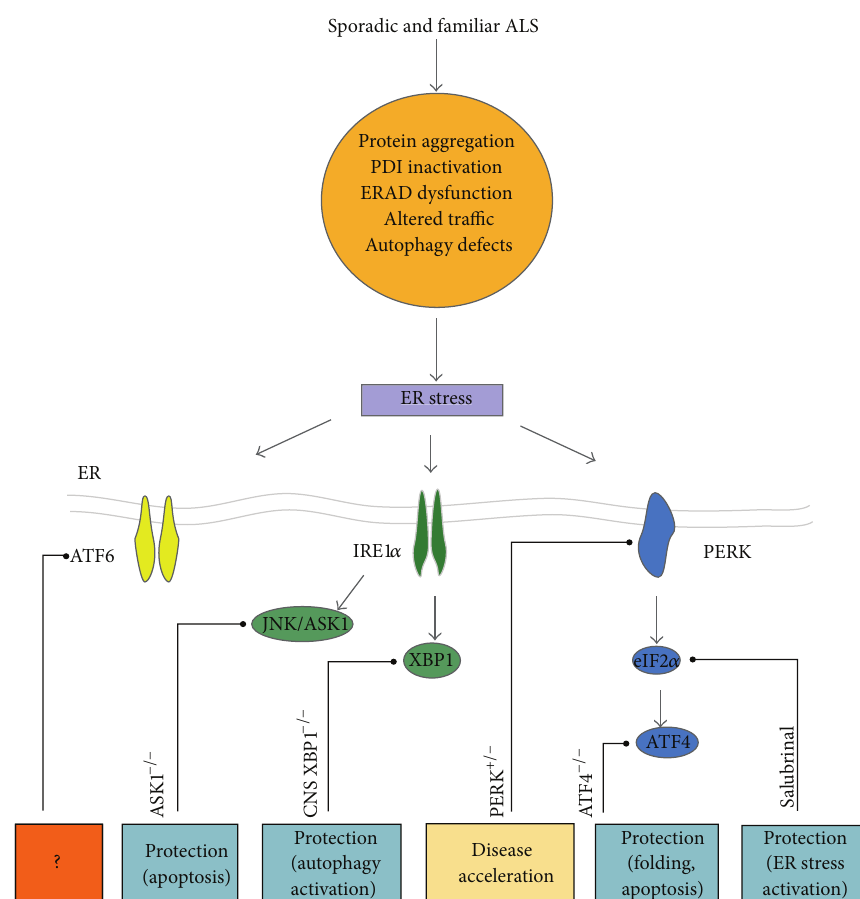
Figure 2: Targeting the UPR in ALS. Different factors may induce ER dysfunction in ALS. For example, abnormal protein aggrega- tion/misfolding, PDIs inactivation by nitrosylation, ERAD dysfunction, altered vesicle traffic, and/or autophagy defects represent conditions that could induce ER stress and lead to an adaptive stress response known as the unfolded protein response (UPR) at early disease stages. The manipulation of different UPR components has revealed a functional contribution of distinct ER stress signaling events in preclinical models of ALS. Genetic targeting of ASK1 (ASK1 −/− ), a downstream signaling component of IRE1 𝛼 , protects against the development of experimental ALS decreasing motor neuron death in the spinal cord of mutant SOD 1 G 93 A mice [56]. The deletion in the CNS of the transcription factor XBP1 (CNS XBP1 −/− ) increases the survival of the mutant SOD 1 G 86 R mice, associated with reduced accumulation of mutant SOD1 aggregates in vivo and enhanced autophagy levels [31]. PERK haploinsufficiency (PERK +/− ) enhanced the severity of experimental ALS, associated with elevated levels of neuronal loss and mutant SOD1 aggregation [43]. The deletion of the transcription factor ATF4 (ATF4 −/− ) in the SOD 1 G 86 R mutant mice delays the appearance of the symptoms and the extended animal survival. These effects were associated to changes in the ER protein folding network and apoptotic genes [63]. In a pharmacological strategy, the treatment of mutant SOD1 mice with a small molecule that selectively induces eIF2 𝛼 phosphorylation, salubrinal, protects against disease progression [52]. No manipulation of ATF6 in animal models of ALS has been